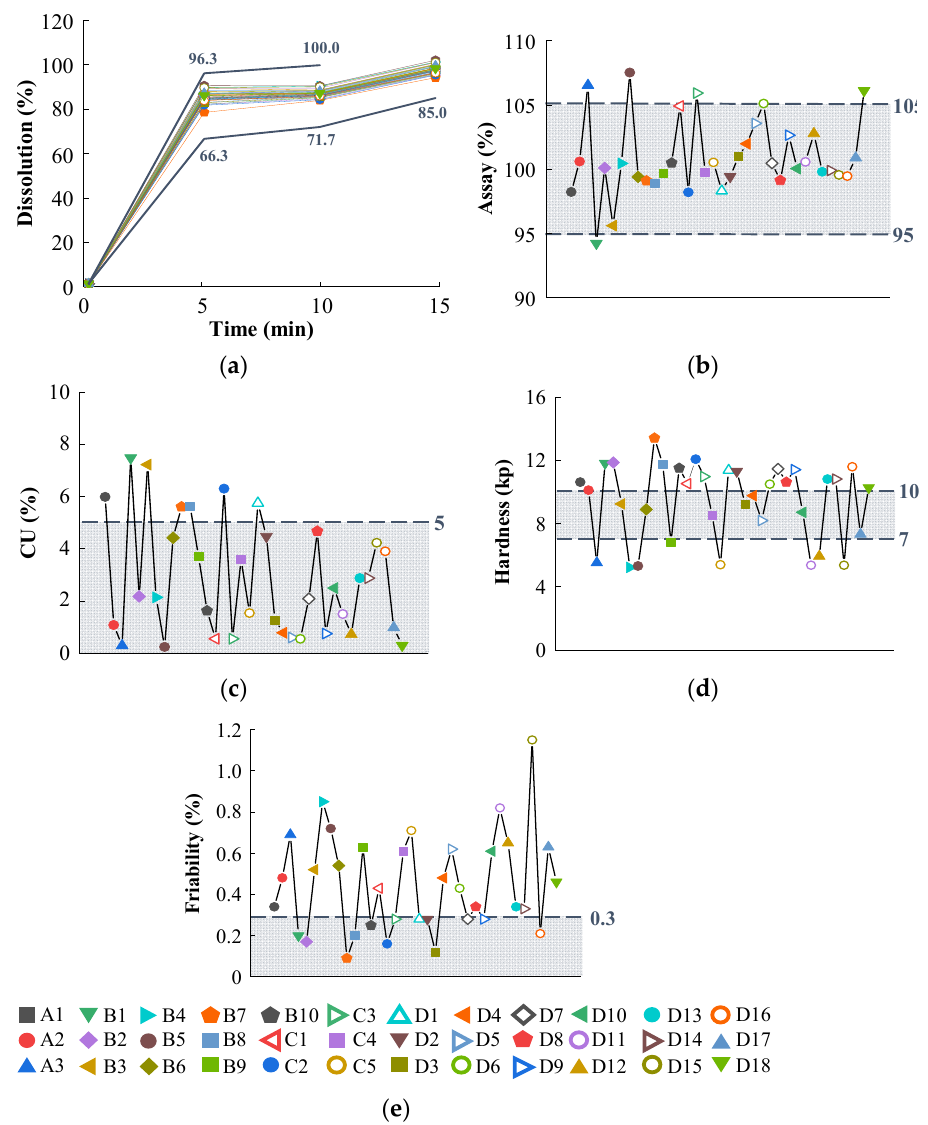
Figure 3. The CQAs of 36 different MCCs; ( a ) Dissolution; ( b ) Assay; ( c ) Content uniformity; ( d ) Hardness; ( e ) Friability. The gray dotted lines and box indicate the optimal ranges of CQAs. (CQA, critical quality attribute; MCC, microcrystalline cellulose).